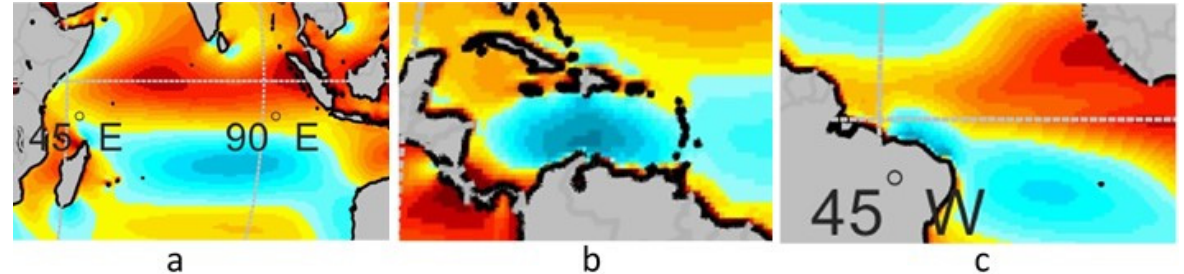
Figure 7. Trade wind areas with annual mean operability over 75%. ( a ) Indian Ocean. ( b ) Caribbean Spot and ( c ) North-eastern Brazil. Color scale is the same as Figure 6.